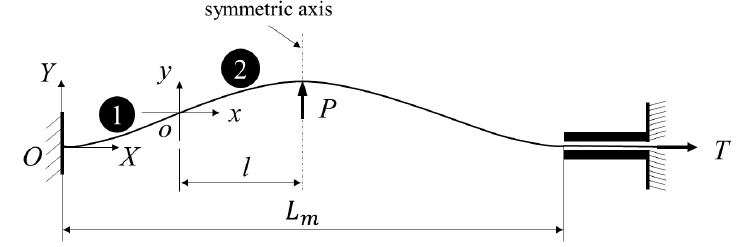
Figure 7. Schematic of free bending.